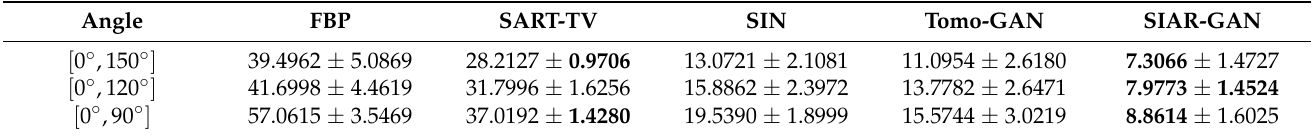
Table 3. Average RMSE results (mean ± standard